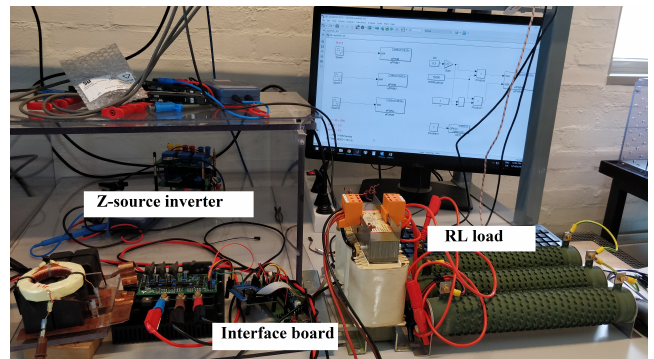
Figure 10. Experimental test bench.